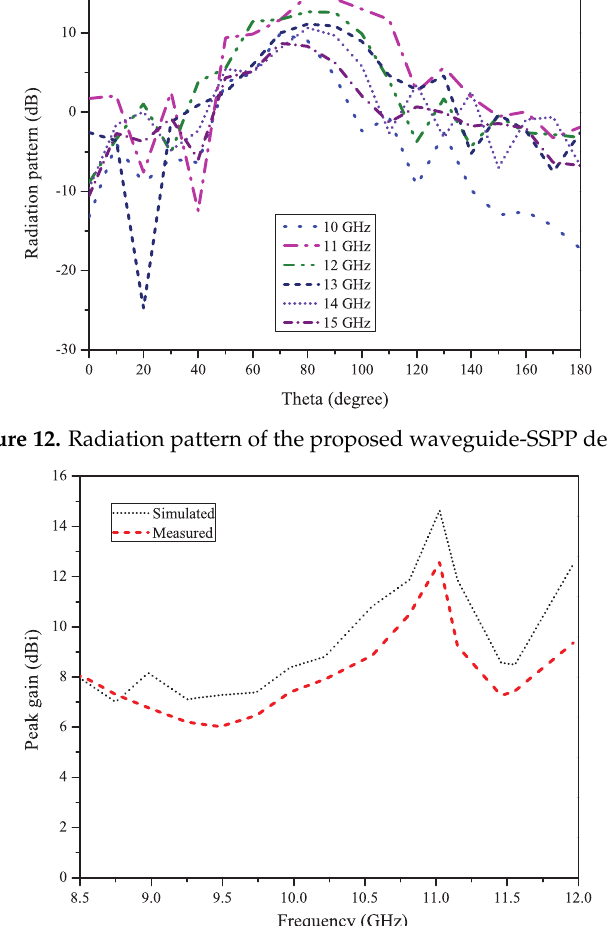
Figure 13. Measured peak gain of the proposed hybrid waveguide-SSPP design.